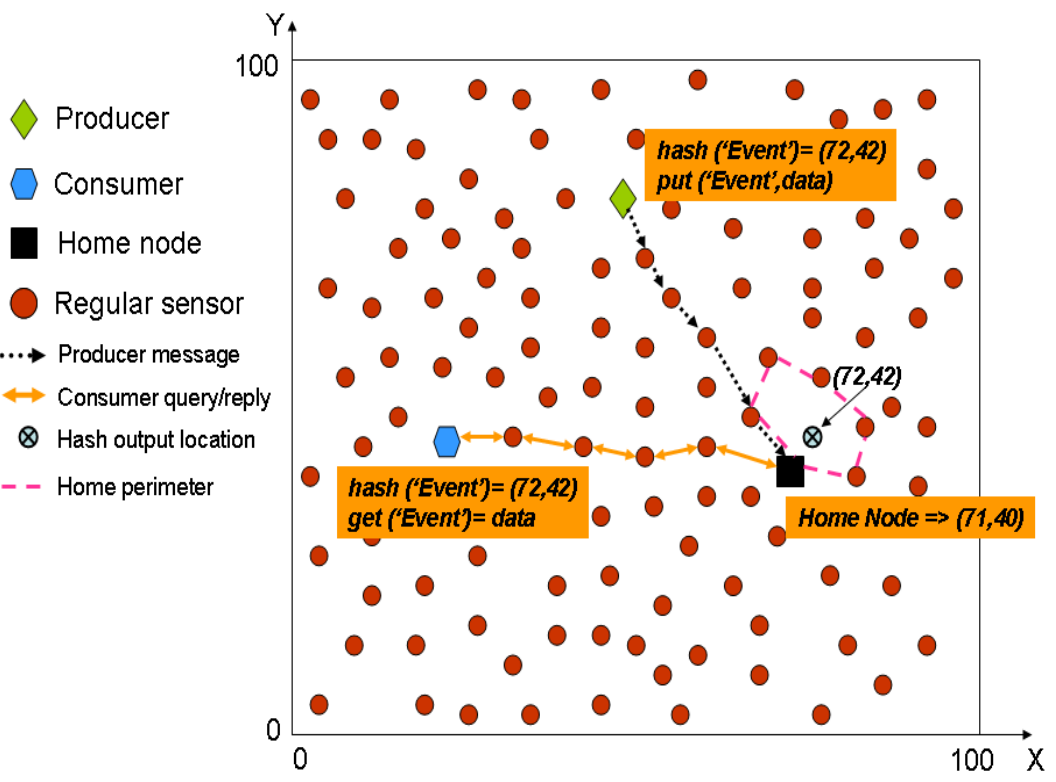
Figure 1. Geographic Hash Table (GHT)